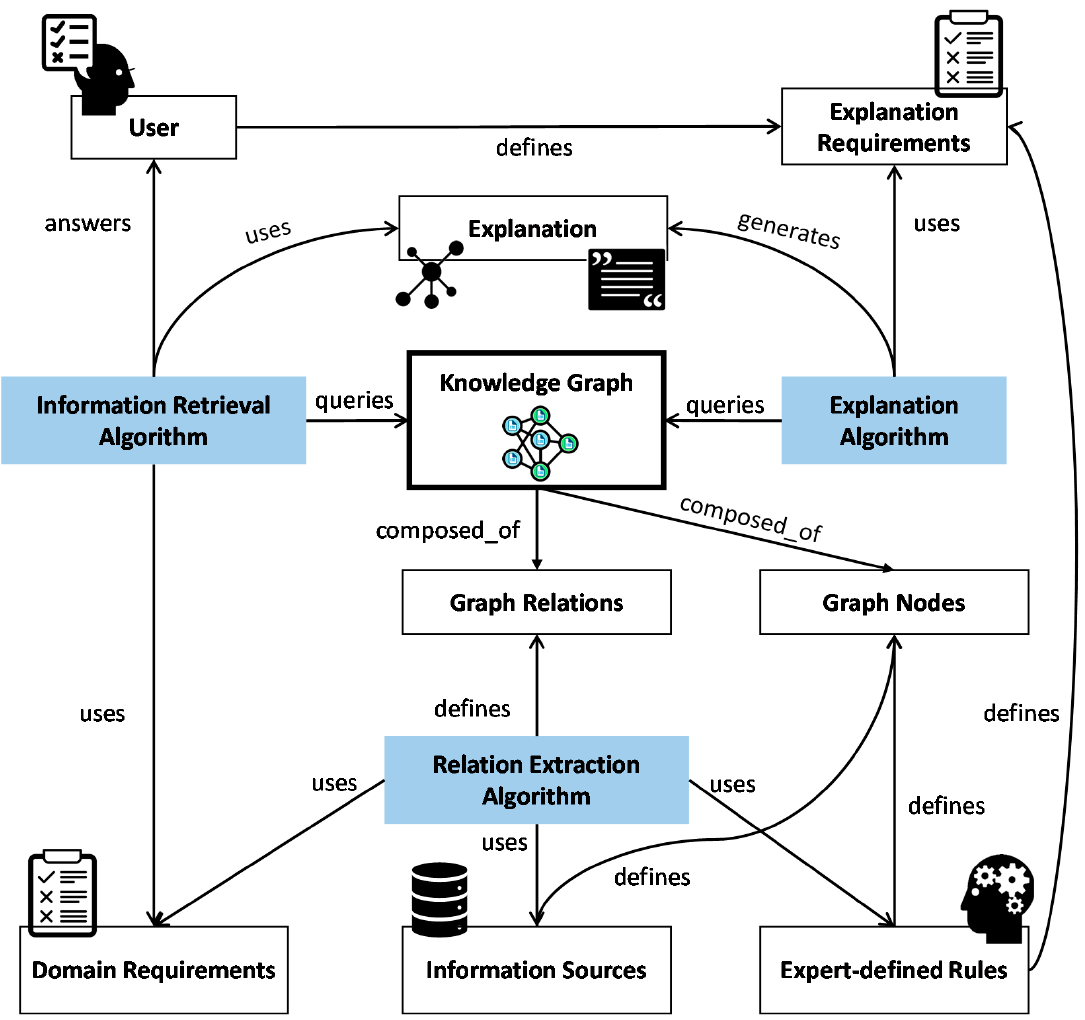
Figure 1. Proposed framework for transferrable, domain oriented, explainable IR, based on knowledge graphs. Domain-specific elements are shown in white, while domain-agnostic algorithms are shown in blue.